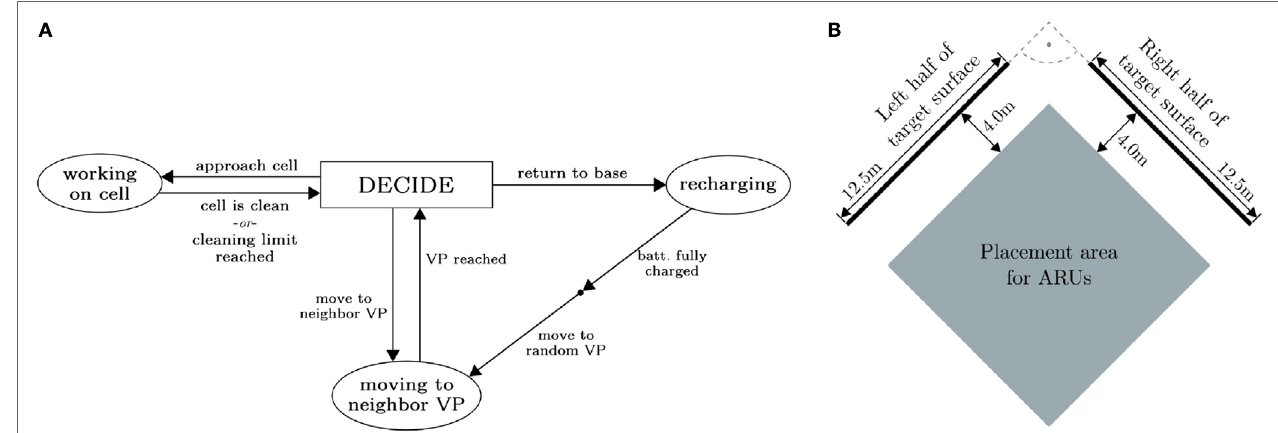
FigUre 6 | (a) Options of activity of a facade maintaining quad-rotor agent. Any activity – working on one of the cells ahead, flying to the base station to recharge, or moving to a neighboring vantage point – is initiated by the decision component, which considers the agent’s battery state and the surface configuration in its field of view. (B) Simulated environment for collaborative surface maintenance evaluation. Two flat surfaces are presented to the quad-rotor swarms as target area, which needs to be cleaned. The base stations of the swarm individuals are randomly placed in the rectangular area between the surfaces. Both figures © von Mammen et al. (2016) CC BY-NC-SA